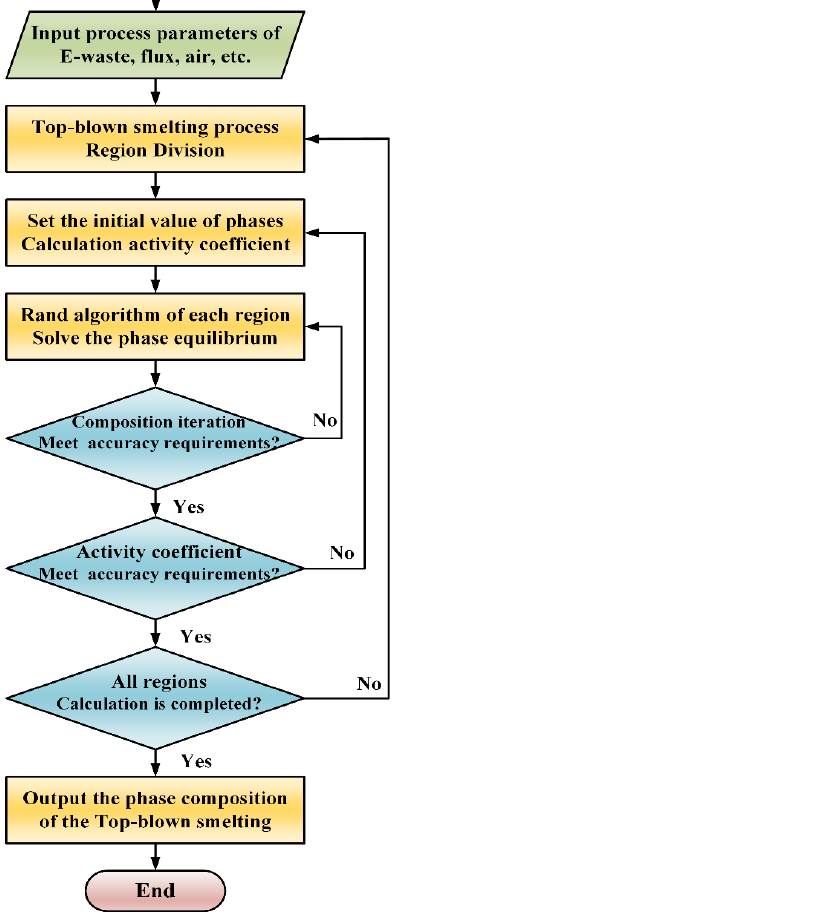
Figure 3. The mathematical model calculation process for the top-blowing smelting process of electronic waste.